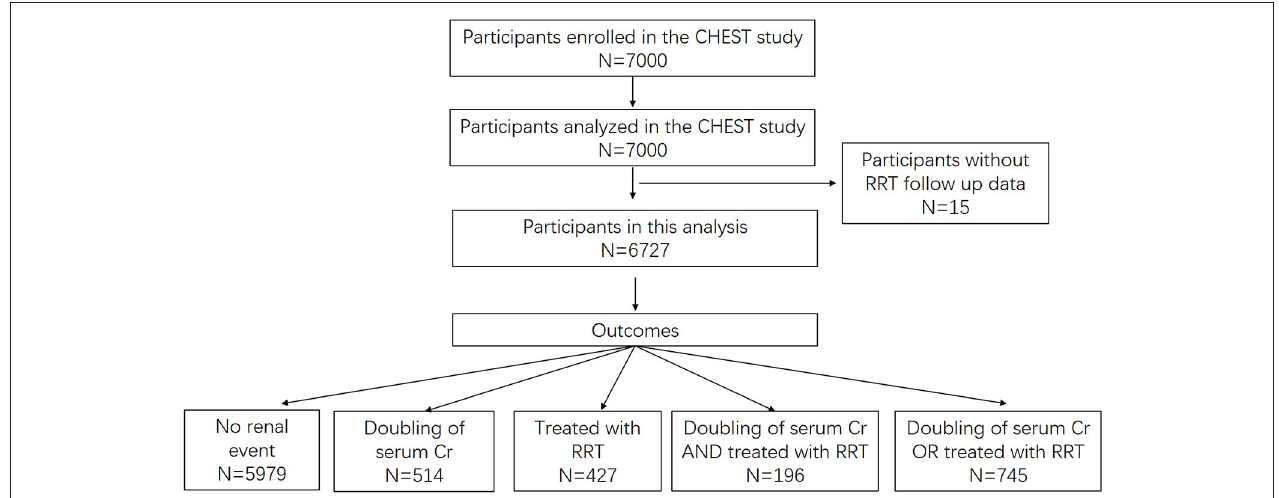
FIGURE 1 | Participant flow diagram. Cr, creatinine; RRT, renal replacement treatment.